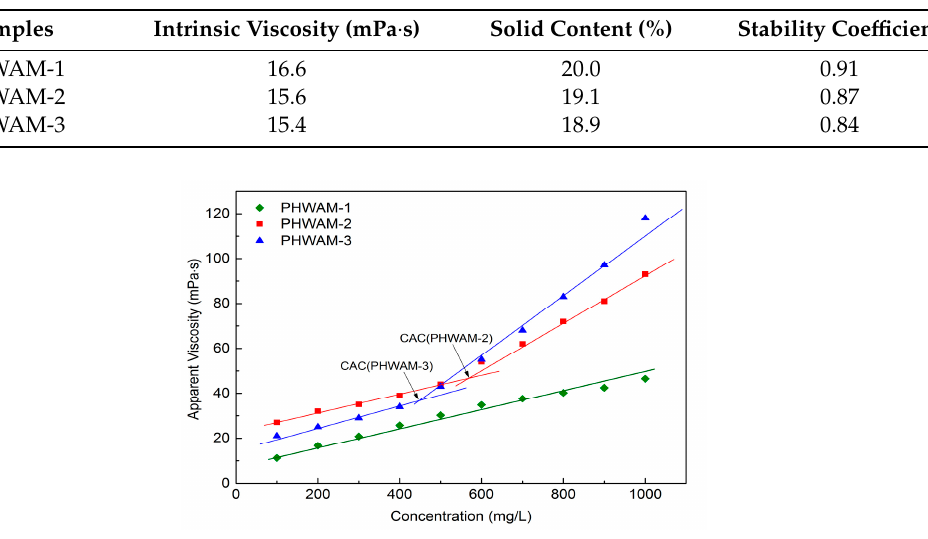
Figure 3. The critical association concentration (CAC) of drag reducer polymers.